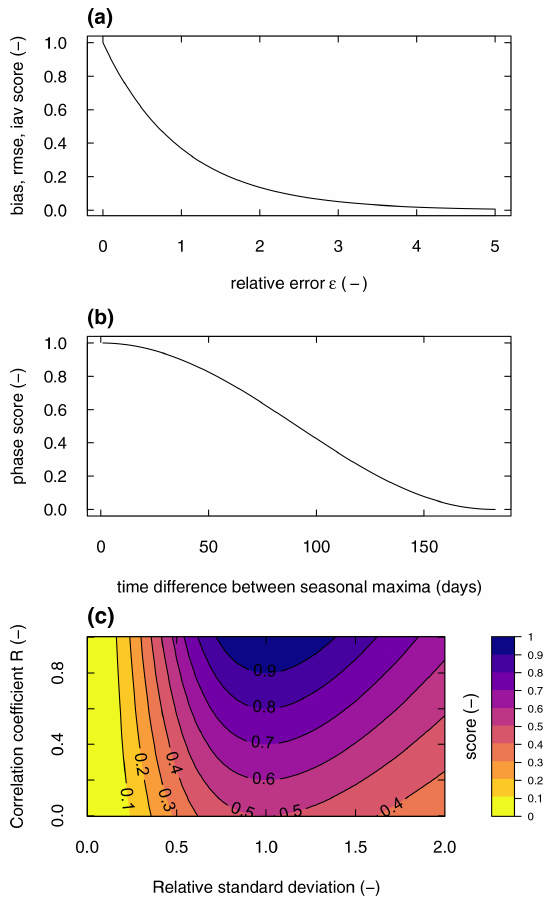
Figure 4. Score functions for (a) bias, root-mean-square error, and interannual variability, (b) seasonality, and (c) spatial